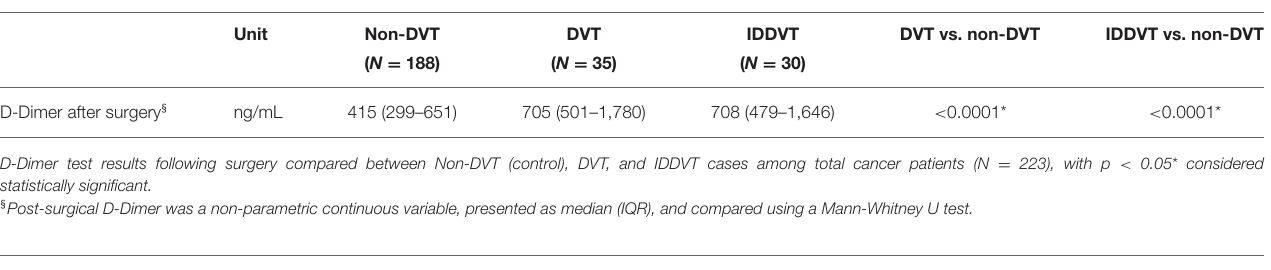
TABLE 4 | Post-surgical D-Dimer as a predictor of IDDVT after thoracic surgery.